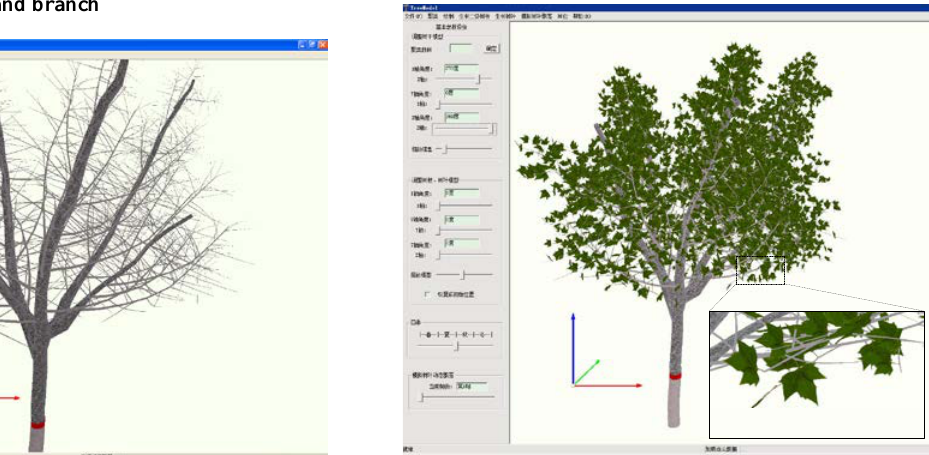
Figure 1. Final trunk model